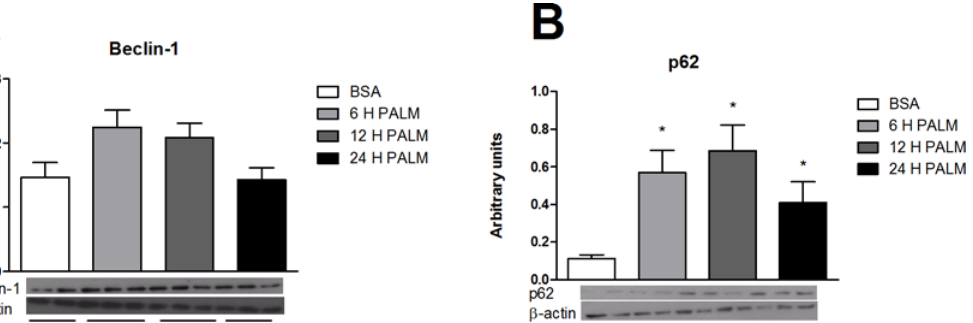
Fig 8. Effect of saturated fatty acid in a neuron cell line. E . Western-blotting shows the Beclin-1 and p62 to β -actin ratio, respectively in CLU-189 cell line treated with 500 μ M of palmitic acid for 6, 12 or 24 hours. Values are shown as mean ± SEM. * P <